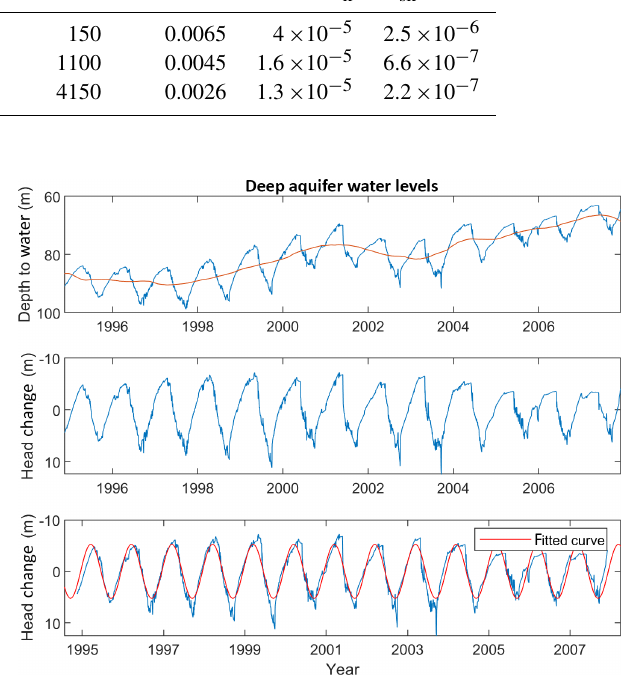
Figure 3. (a) long term compaction (blue) with trend line (orange), (b) long-term compaction trend removed to reveal annual com- paction pattern over period of record, and (c) annual compaction (blue) with sine wave fit (orange) showing mean frequency and amplitude of annual elastic compaction due to persistent seasonal pumping patterns.